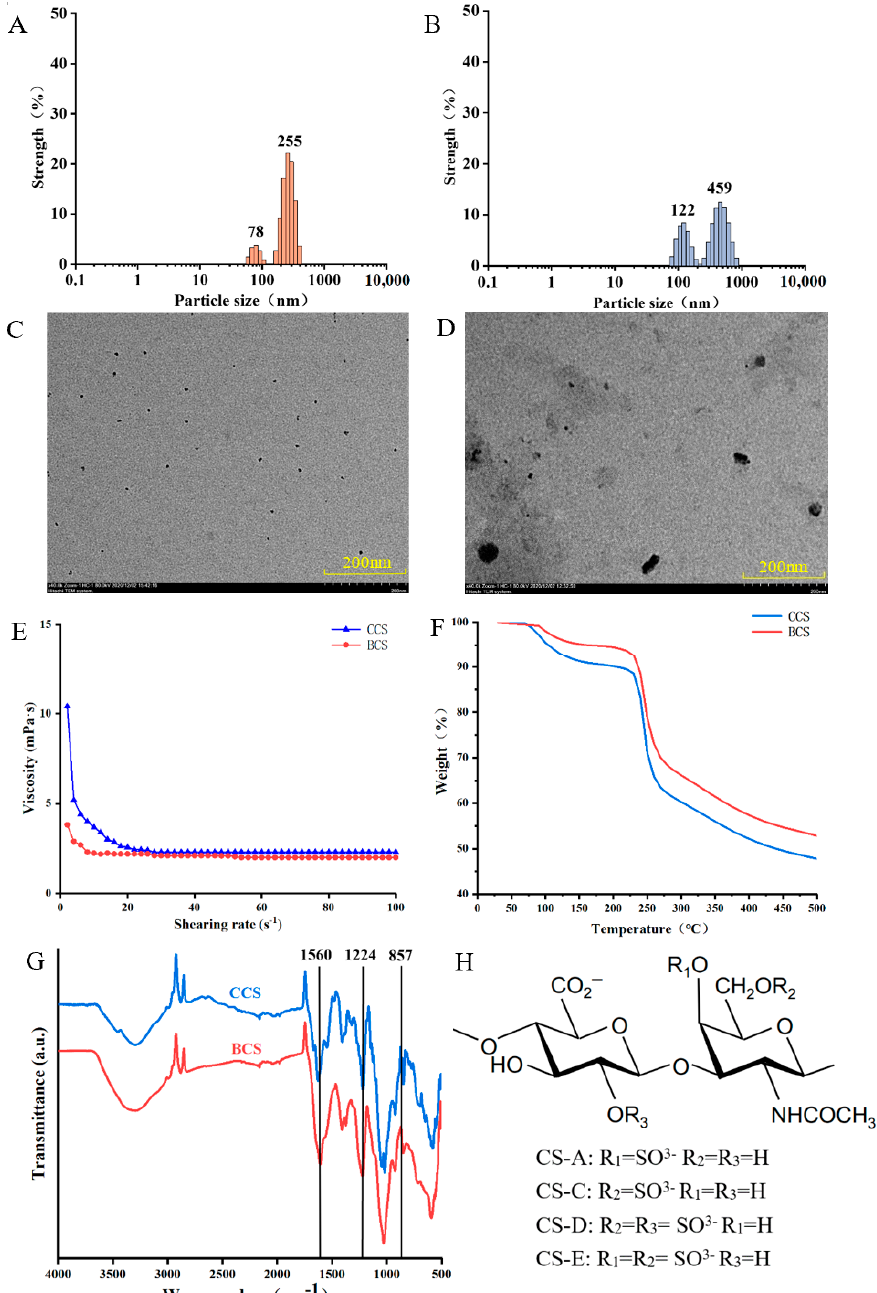
Figure 1. Characteristics of the CCS and BCS particles. Particle size distribution of ( A ) CCS and ( B ) BCS. The average particle size for each peak is marked. TEM images of ( C ) CCS and ( D ) BCS. ( E ) Viscosity curves of CCS and BCS in the shear rate range of 0–100 s − 1 . ( F ) TGA curves of CCS and BCS. ( G ) FTIR spectra of CCS and BCS. ( H ) Structural formula of CS.